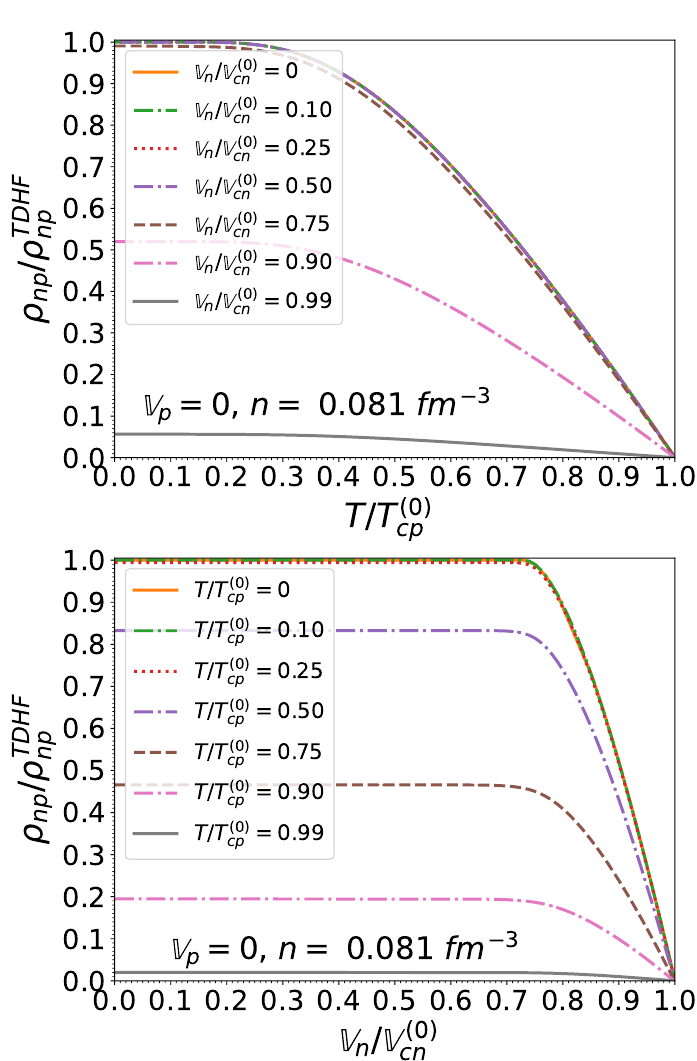
Figure 14. Dimensionless entrainment matrix element ρ np / ρ TDHF np as a function of the normalized ( 0 ) effective superfluid velocity V n / V cn and the normalized temperature T / T beta-equilibrium at the crust-core interface and for V p =